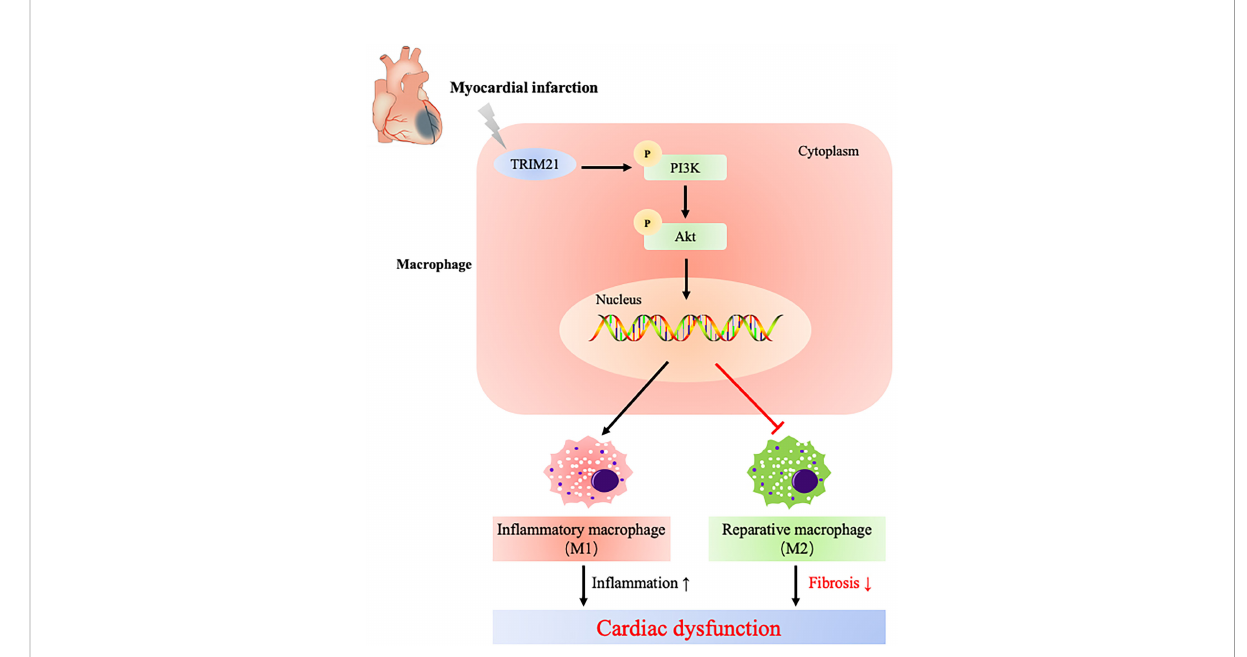
FIGURE 8 Schematic diagram illustrates that TRIM21 mediates macrophage polarization via PI3K/Akt pathway after myocardial